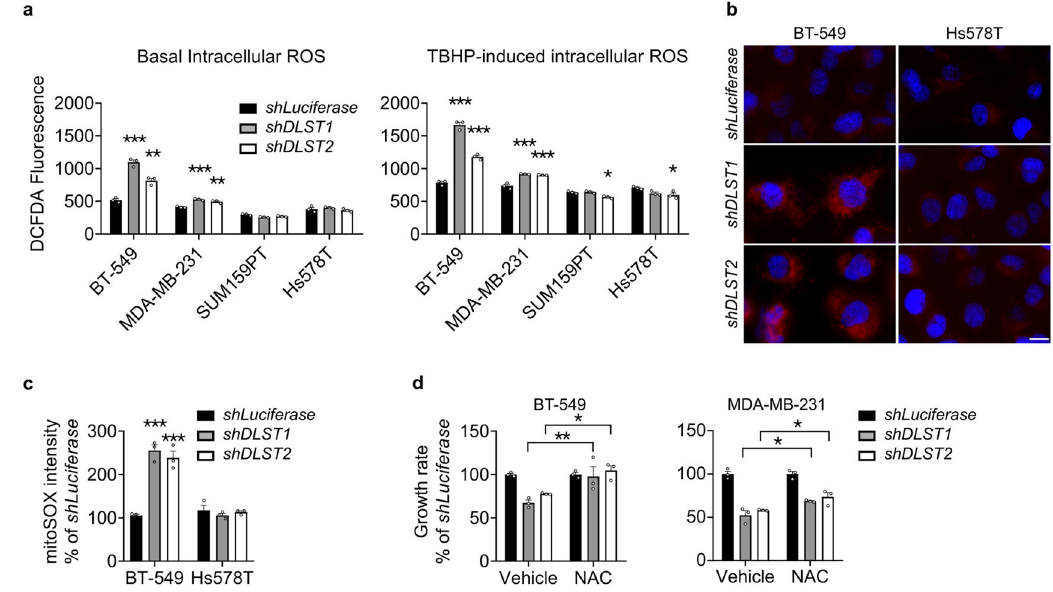
Fig. 5 DLST depletion induces ROS production in DLST-dependent human TNBC cells. a In the late evening of day 4 post-transduction, ROS levels in four TNBC cell lines are measured using 2,7 ′ -dichloro fl uorescin diacetate (DCFDA) dye with (right) or without (left) TBHP treatment ( n = 3; representative data from three independent experiments). Statistical differences were calculated using one-way ANOVA. b , c Mitochondrial ROS levels analyzed by mitoSOX staining in BT-549 and Hs578T cells in the presence or absence of DLST knockdown in the evening of day 4 post-transduction. Representative images of mitoSOX staining ( b ; red overlaid with DAPI staining) and image quanti fi cation ( c ) are shown ( n = 3; representative data from three